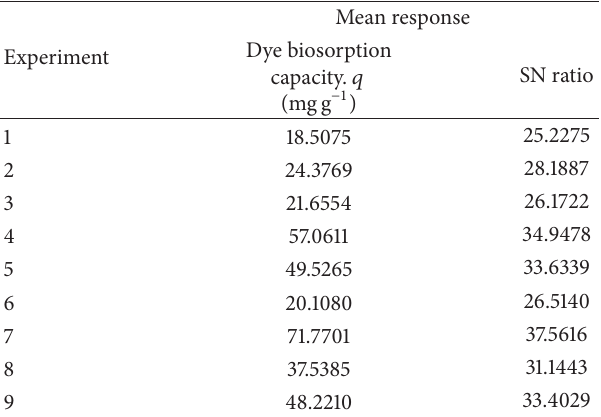
Table 2: Dye biosorption capacity and SN ratio value obtained